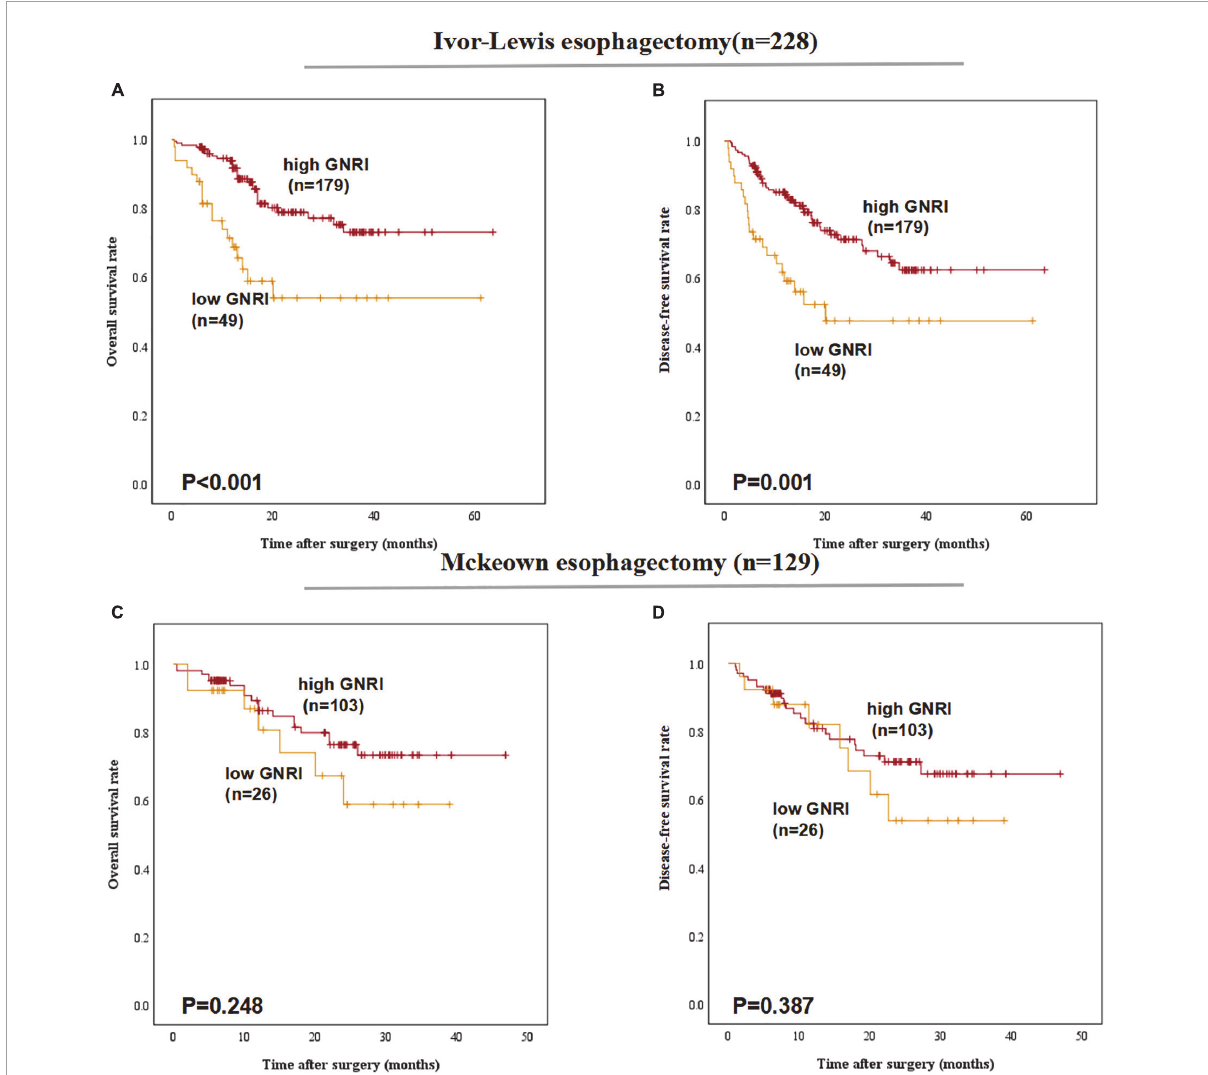
FIGURE3 Postoperative outcomes of patients with high or low geriatric nutritional index (GNRI) basing on different surgery types: (A) overall survival, (B) disease-free survival of esophageal squamous cell carcinoma (ESCC) patients underwent Ivor-Lewis esophagectomy ( n = 228), (C) overall survival, and (D) disease-free survival of ESCC patients underwent Mckeown esophagectomy ( n =